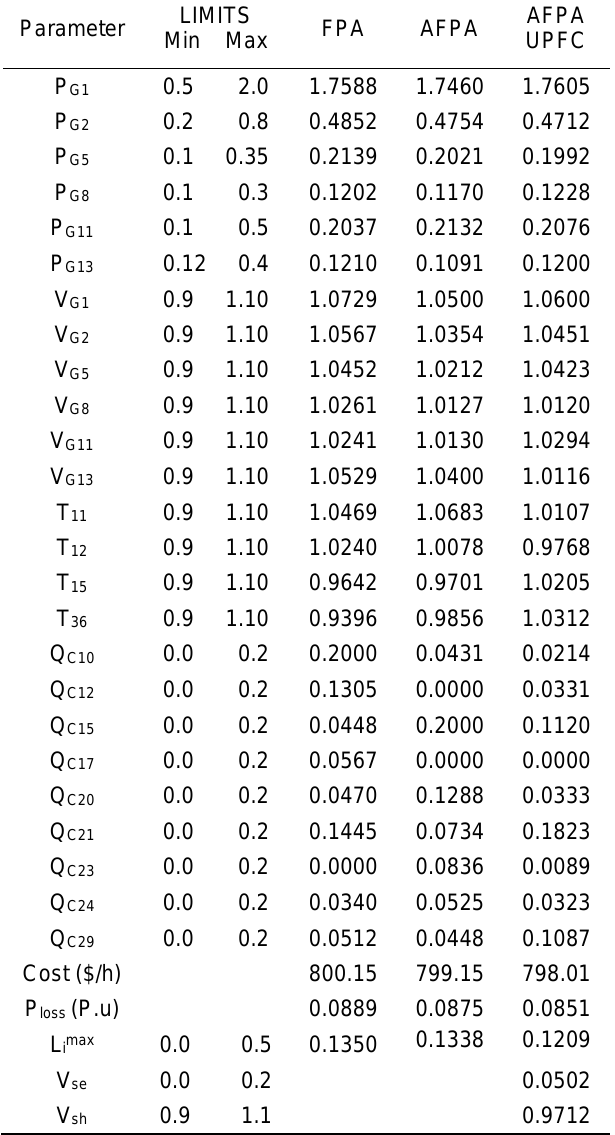
Table 3. Simulation results of FPA, AFPA & AFPA-